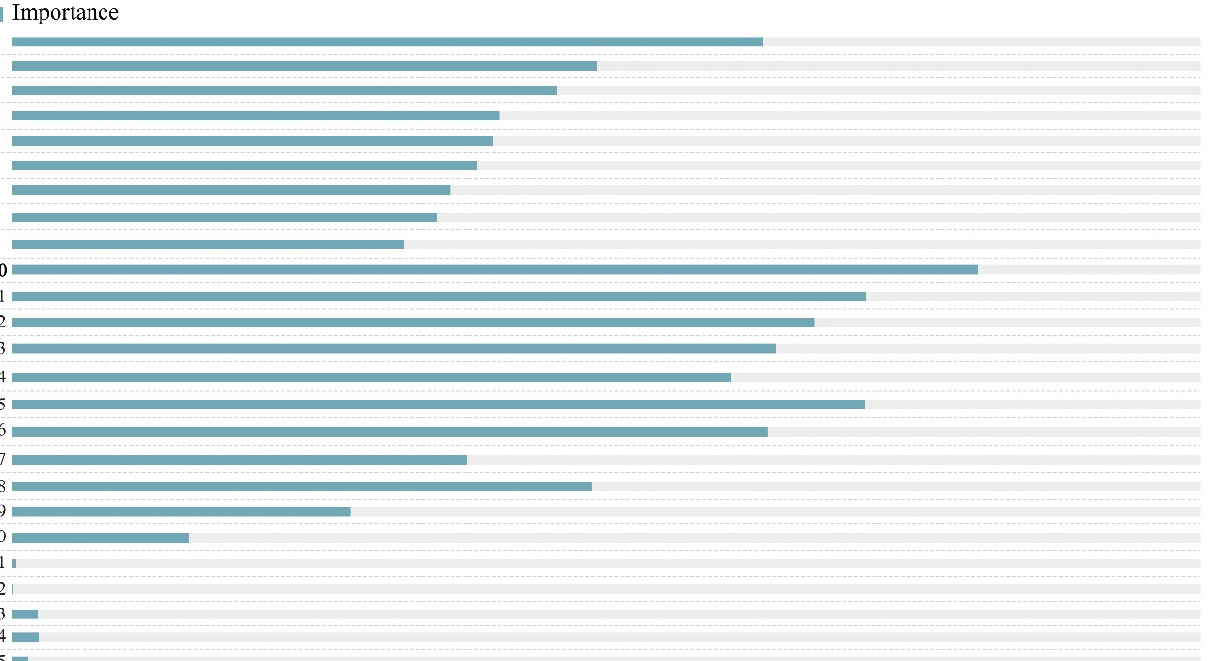
Figure 5. Importance ranking of each indicator based on the random forest algorithm (see Table 2 for the description of X1 ‒ X25).